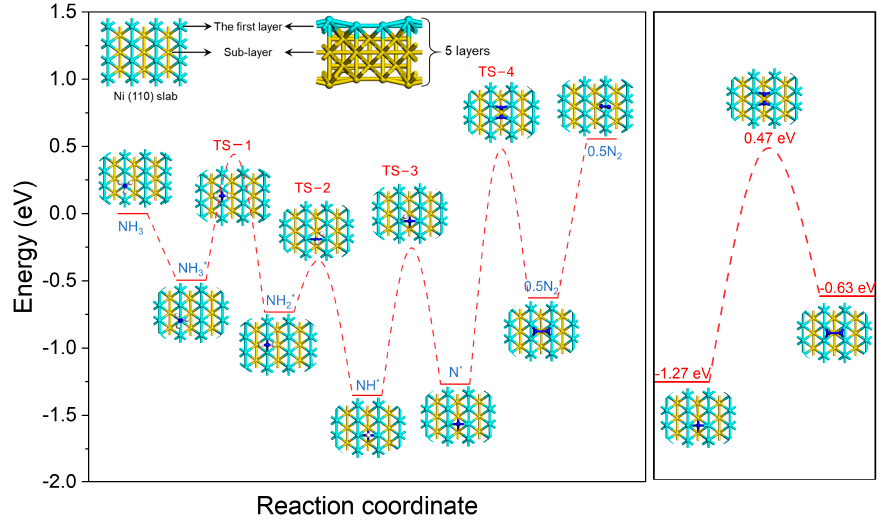
Figure 7. The potential energy profiles of ammonia decomposition over Ni (110) surface.